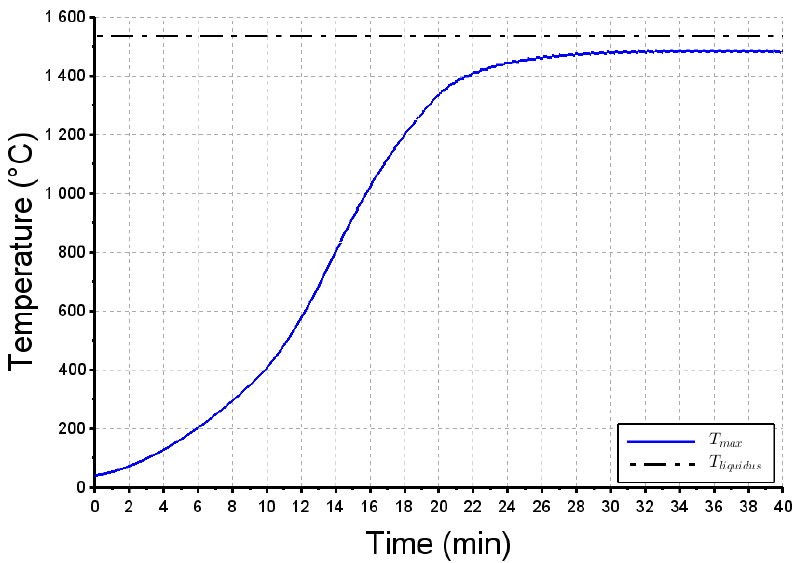
Figure 10. Maximum temperature calculated within the charge vs time. 𝑇 𝑙𝑖𝑞𝑢𝑖𝑑𝑢𝑠 = 1536 °C . As stated previously, ten thermocouples have been installed within the steel ball layer (their location is shown in Figure 3). The actual and simulated thermograms are reported in Figures 11 and 12 respectively, for the 40 min of the melting trial. Again, all temperatures are much lower than the steel liquidus temperature, which implies that no liquid pool was formed during this melting operation. At the beginning of the experiment, the thermocouples 𝑡c 6 and 𝑡c 8 reached higher temperatures than the other ones. It could be explained by some rare infiltrations of metal within the initial bed of steel balls. Obviously because the infiltrations are not modelled, their thermal effect cannot be obviously observed in the numerical results. The other thermocouples display a similar dynamic behavior. We can observe a significant time-lag (around 10 min) required for the heat to diffuse from the top surface to the location of the thermocouples, followed by a temperature increase at a rate lying between 35 and 50 °C/min. Finally, the maximum temperature (800–1050 °C) was reached at t = 25 min. The calculated curves (Figure 12) match relatively well with these dynamics, showing a characteristic S-shape for a diffusive transfer. This is particularly true for the group of thermocouples ( t c 3 , t c 7 , t c 9 and t c 10 ) where the dynamic behaviour (heating rate around 50 °C/min) and the maximum temperature (around 1000 °C) are well simulated. The agreement appears however weaker for another group of thermocouples ( t c 1 , t c 2 , t c 4 and t c 5 ) since the time-lag and maximum temperatures do not match properly. This could be explained by the mediocre filling of the crucible with the incoming partly liquid steel.